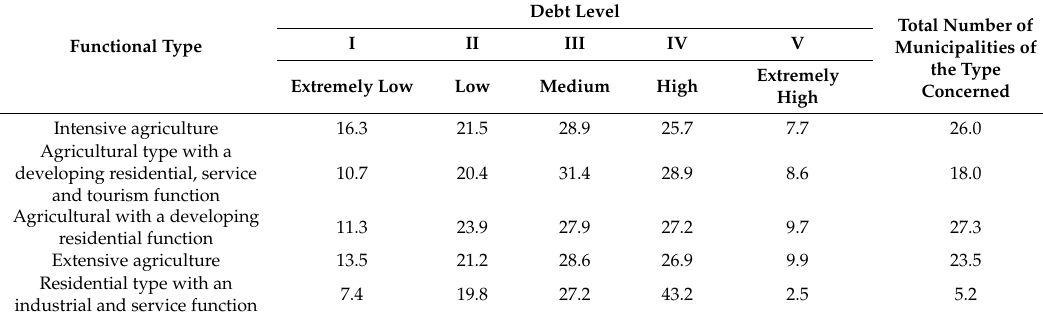
Table 6. Characteristics of Polish rural municipalities grouped by debt level and functional type in 2015–2017 (% of rural municipalities of each functional